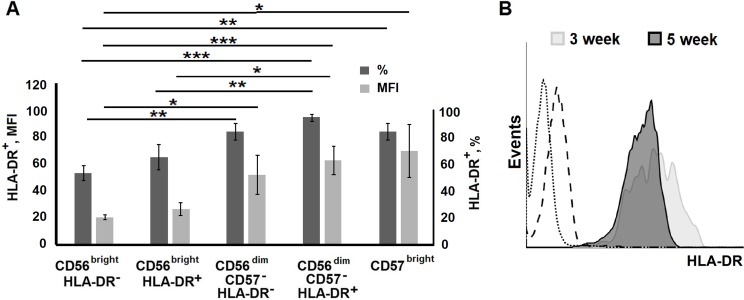
Surface expression of HLA-DR in NK cell clones.(A) HLA-DR expression levels in clones derived from different NK cell subpopulations analyzed at week 5 of cultivation. Proportions of HLA-DR+ cells and MFI of HLA-DR+ cells (mean ± SE) of n independent experiments are presented: n = 12 for CD56brightHLA-DR–, n = 9 for CD56brightHLA-DR+, n = 10 for CD56dimCD57–HLA-DR–, n = 13 for CD56dimCD57–HLA-DR+ and n = 11 for CD56dimCD57bright. (B) HLA-DR surface expression in a NK cell clone from CD56dimHLA-DR+ subset measured at weeks 3 and 5. The dotted line indicates autofluorescence, dashed line is the isotype control.